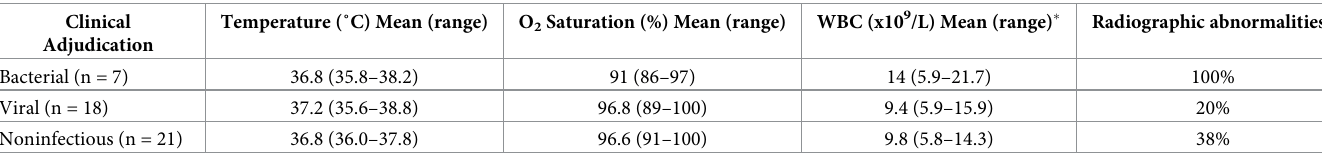
Table 2. Clinical data from asthma exacerbation cohorts. Clinical